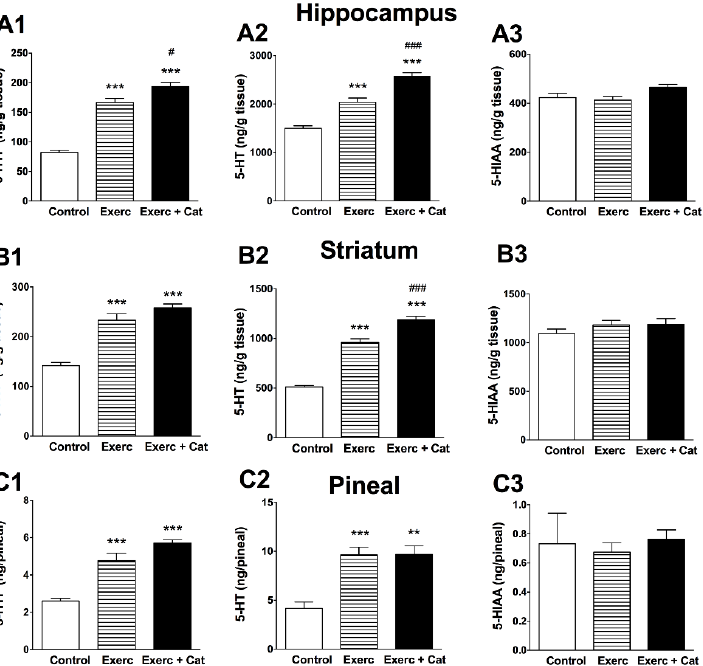
Figure 3. Effect of exercise and the combined action of exercise and catechin treatment on TPH-2 enzyme activity in the hippocampus ( A ) and striatum ( B ), and the effect on TPH-1 enzyme activity in the pineal gland ( C ) of aged rats. Bars represent the mean ± SEM of 5-HTP accumulation (after inhibition of decarboxylation with NSD-1015 for 30 min) ( A1 , B1 , C1 ), 5-HT levels ( A2 , B2 , C2 ) and 5-HIAA metabolite ( A3 , B3 , C3 ) in extracts from the hippocampus and striatum (ng/g) and ng in the entire pineal gland (ng/pineal) of animals subjected to exercise (Exerc, n = 7) and the exercise plus catechin treatment group (Exerc + Cat, n = 7) versus control group animals ( n = 7). ( A ) One-way ANOVA detected a sig- nificant effect on 5-HTP (F(2,18) = 100.2, p < 0.0001), 5-HT (F(2,18) = 61.74, p < 0.0001) and 5-HIAA (F(2,18) = 3.425, p = 0.05) in the hippocampus. ( B ) One-way ANOVA detected a significant effect on 5-HTP (F(2,18) = 141.2, p < 0.0001) and 5-HT (F(2,18) = 48.73, p < 0.0001), but not 5-HIAA (F(2,18) = 1.232, p = 0.314) in the striatum. ( C ) One-way ANOVA detected a